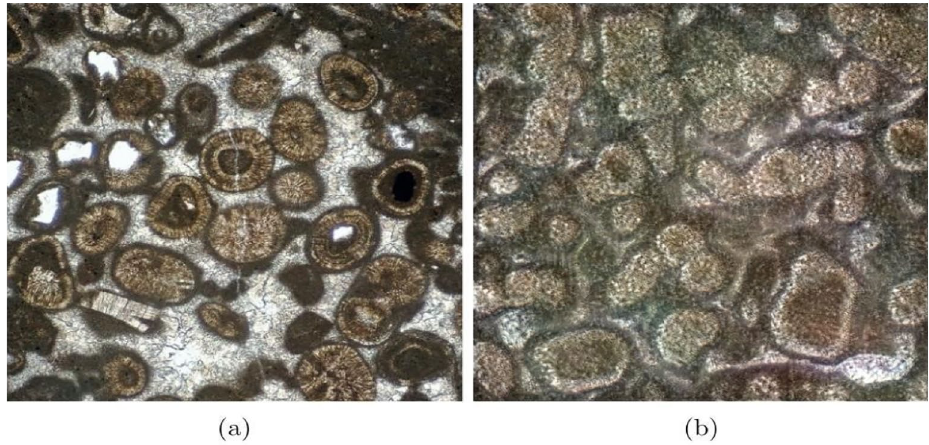
Figure 8. Results of interpolating an image into the model ( a ) Ooilitc limestone 52 , and ( b ) interpolated oolitic limestone in model’s latent